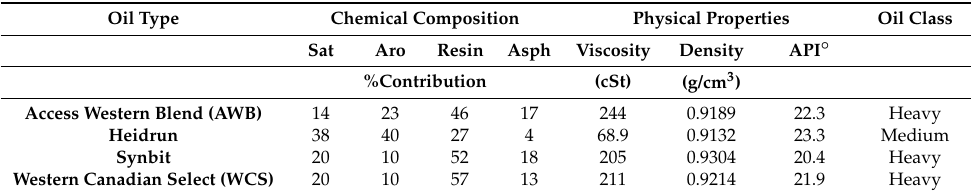
Table 1. Saturates, aromatics, resins and asphaltenes (SARAs) contribution and physical properties for the three oils